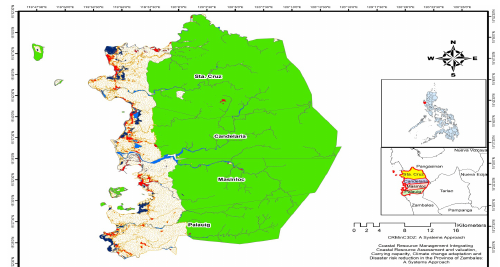
Figure 6. Land cover map of the study area